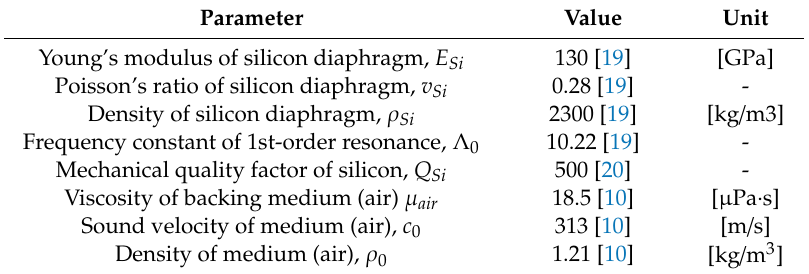
Figure 6. Simulation result: sensitivity–frequency response of the ElGoFET microphone. Table 1. Physical properties used in the simulation for the ElGoFET